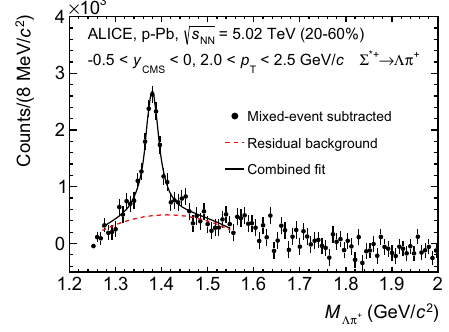
Fig. 2 ( Left ) the (cid:9)π + invariant mass distribution (same-event pairs) in 2.0 < p T < 2.5 GeV / c and for the multiplicity class 20–60%. The backgroundshape,usingpairsfromdifferentevents(mixed-eventback- ground), is normalised to the counts in 1.9 < M (cid:9)π < 2.0 GeV / c 2 .